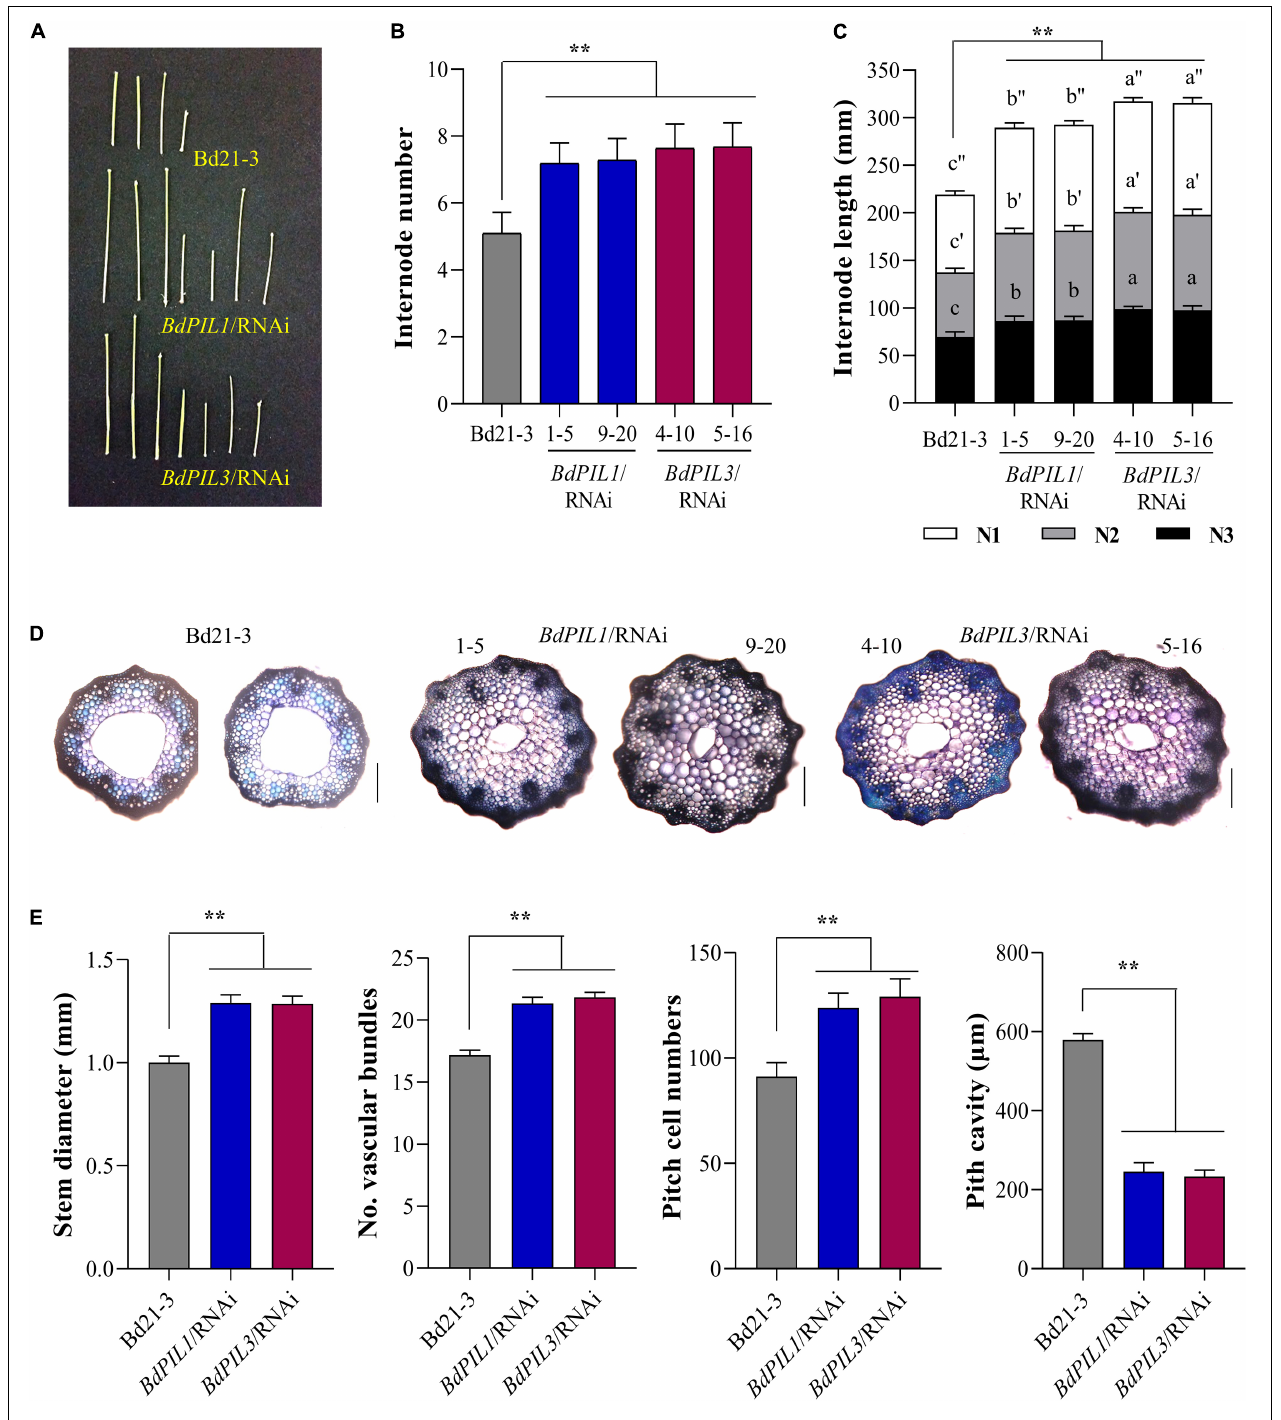
FIGURE 4 | Stem internode elongation in the BdPIL1/ RNAi and BdPIL3/ RNAi plants. (A) Internodes obtained from 6-week-old plants. Scale bar, 3 cm. (B) Average number of internodes in the main stems of 4-month-old plants. (C) Average internode length of the three longest internodes (labeled as N1, N2, and N3 starting from the spikelet) in the main stem of 4-month-old plants. (D) Cross-sections and toluidine blue staining of the internode of the longest stem from 60-day-old plants. Scale bar, 250 µ m. (E) Analysis of stem internodes. Stem diameter, number of vascular bundles and pitch cells, and pitch cavity of the longest internodes of 60-day-old plants were measured. Data represent the means ± SD ( n ≥ 30 for B , C , n = 3 for E ). Different letters in (C) represent significantly different means ( P < 0.01, using Duncan’s multiple range test), and significant differences in comparison to Bd21-3 are indicated in (E) by ** ( P < 0.01, Tukey’s test).